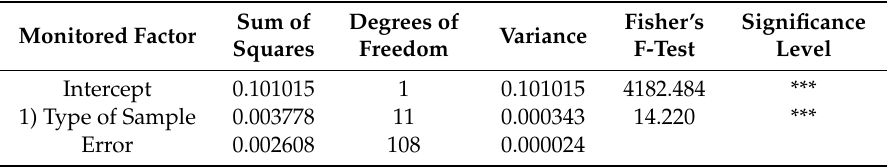
Table 3. Statistical evaluation of the e ff ect of the factors and their interaction on the coe ffi cient of wood bendability ( K bendC ) for aspen and non-wood component (NWC) on the bottom.